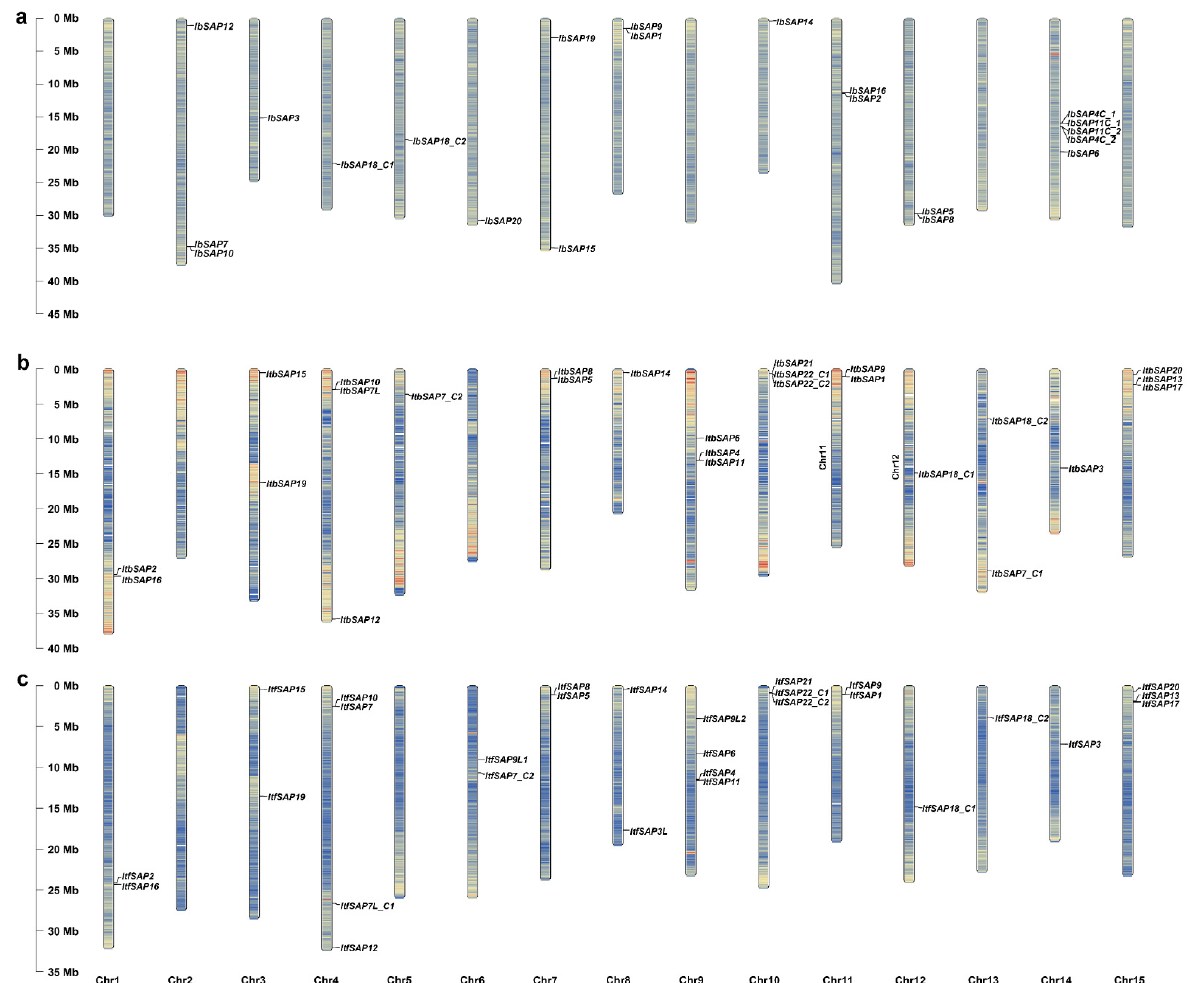
Figure 1. Chromosome localization of SAP genes in I. batatas ( a ), I. triloba ( b ), and I. trifida ( c ). The bars on the left represent the length of chromosomes. The chromosome numbers and gene names are displayed on the left side and right side of chromosomes, respectively.